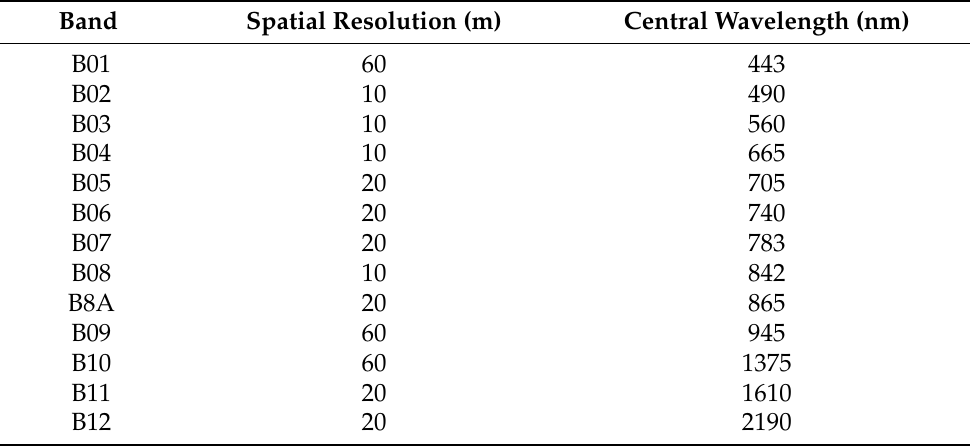
Table 2. Spatial resolution and central wavelength of each band of Sentinel-2 images.